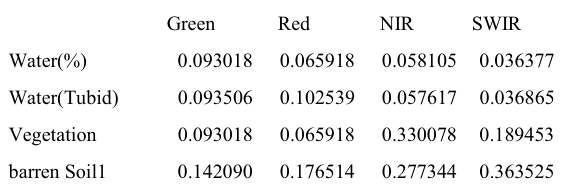
Table 1. TOA reflectance Values of the sample pixels used for sensitivity